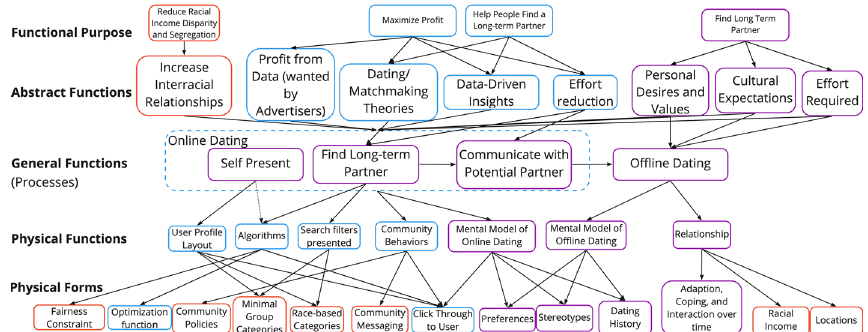
Fig. 1 Our constructed abstraction hierarchy. The five levels of the AH are listed on the left, nodes at each level are boxed phrase, with links connecting boxes between and within levels. Links to the dotted box entitled “Online Dating” connect Abstract Functions to all three of the enclosed General Functions. Nodes are colored to represent the perspective they are relevant to: the Platform (blue), or the User (purple). Additionally, nodes that are directly relevant to the proposed interventions or the primary outcomes are colored